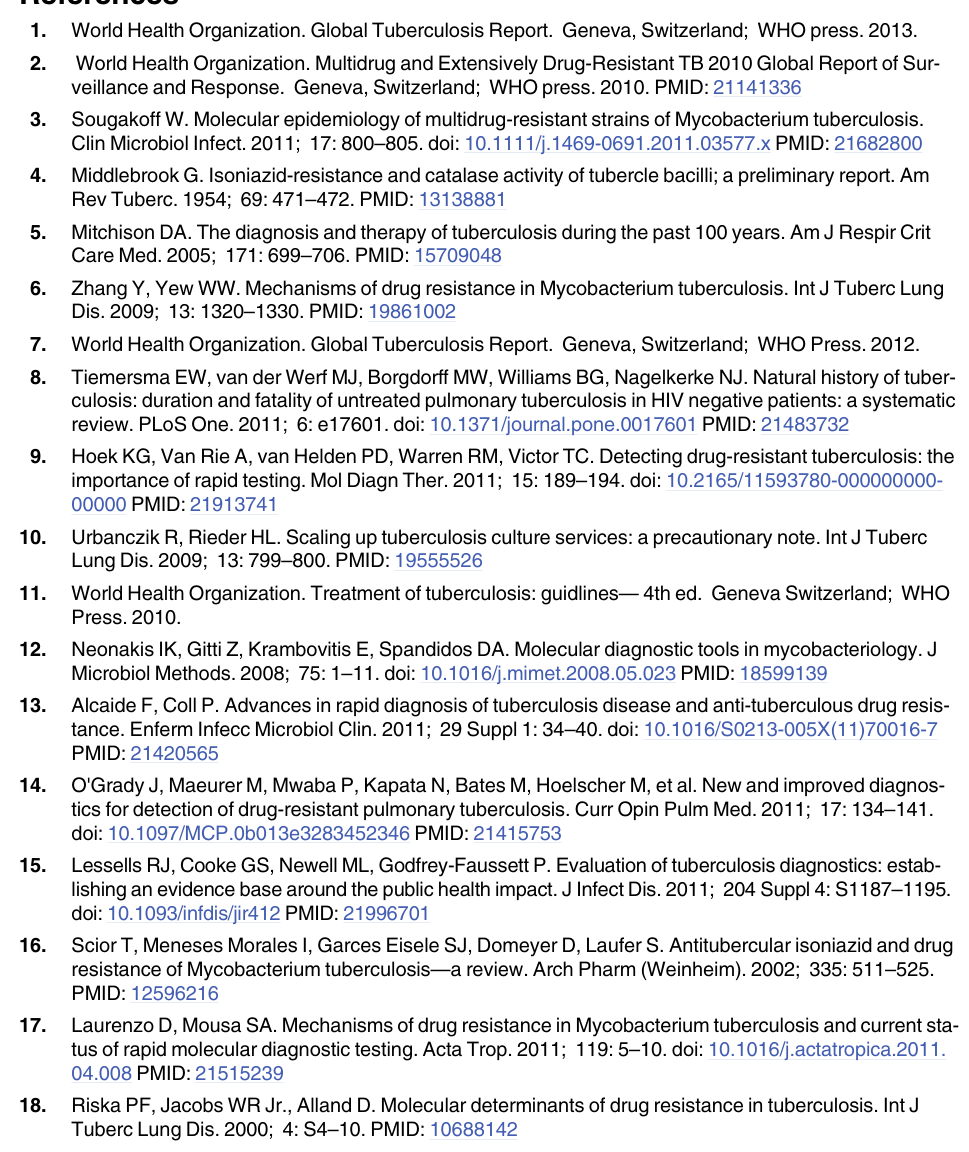
S4 Table. Details of Studies Included in